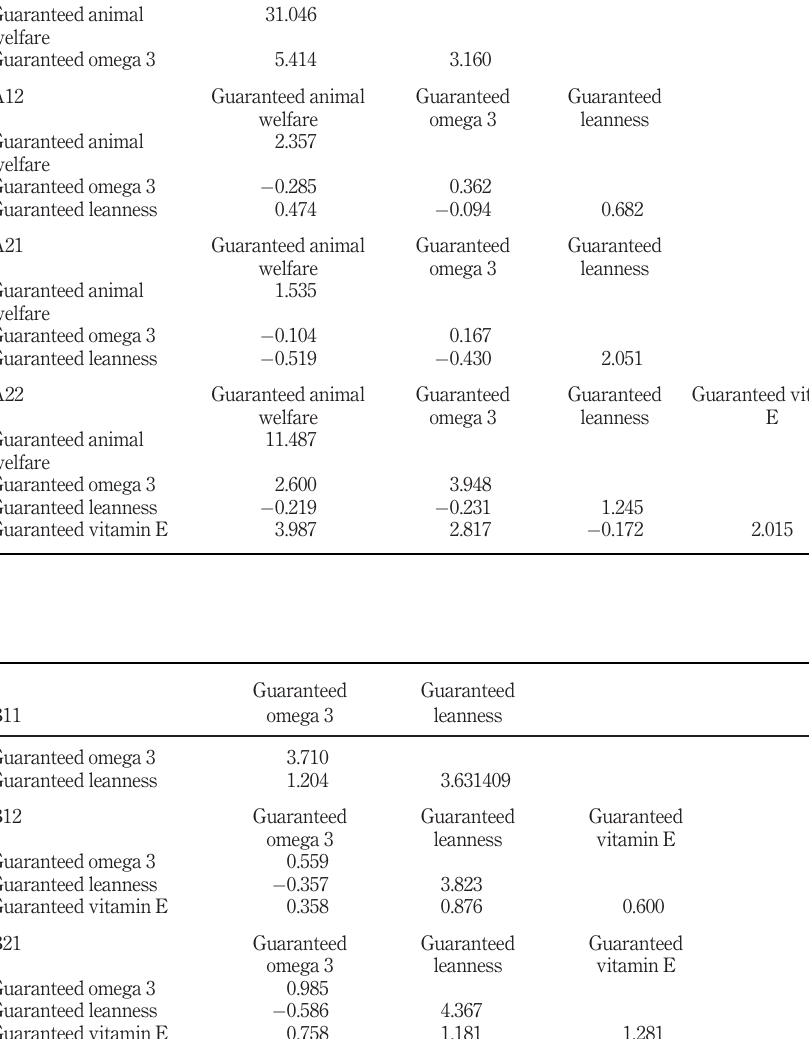
Table 5. Covariance matrix of random parameters for